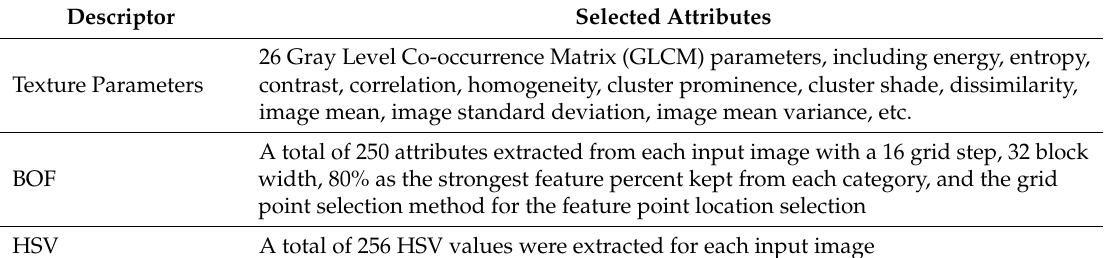
Table 1. The selected attributes for the benthic habitat classification